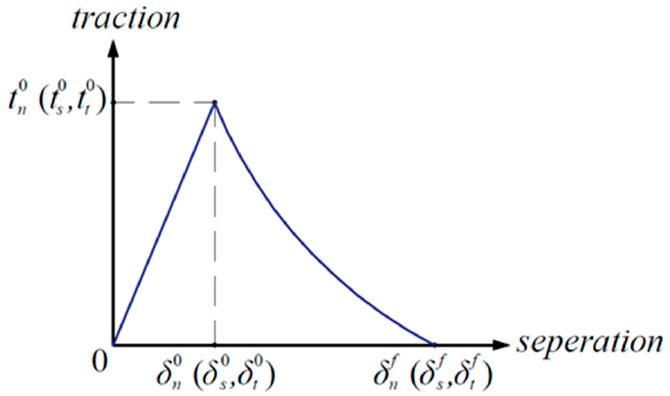
Figure 5. Bond stress observed in the contact surfaces between the concrete and steel bar.